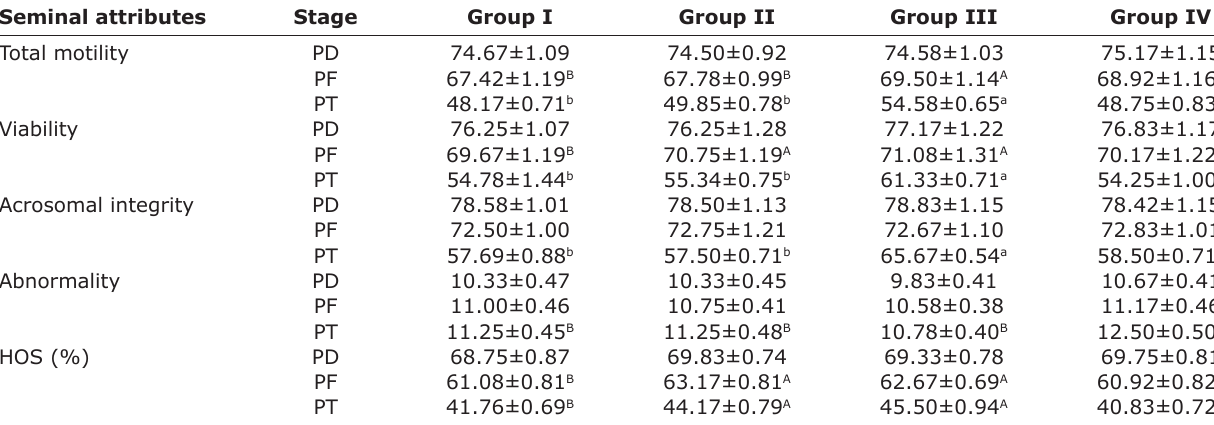
Table-1: Effect of egg yolk powder on seminal attributes and sperm function of buffalo semen at post-dilution, pre-freeze, and post-thaw stage. Seminal